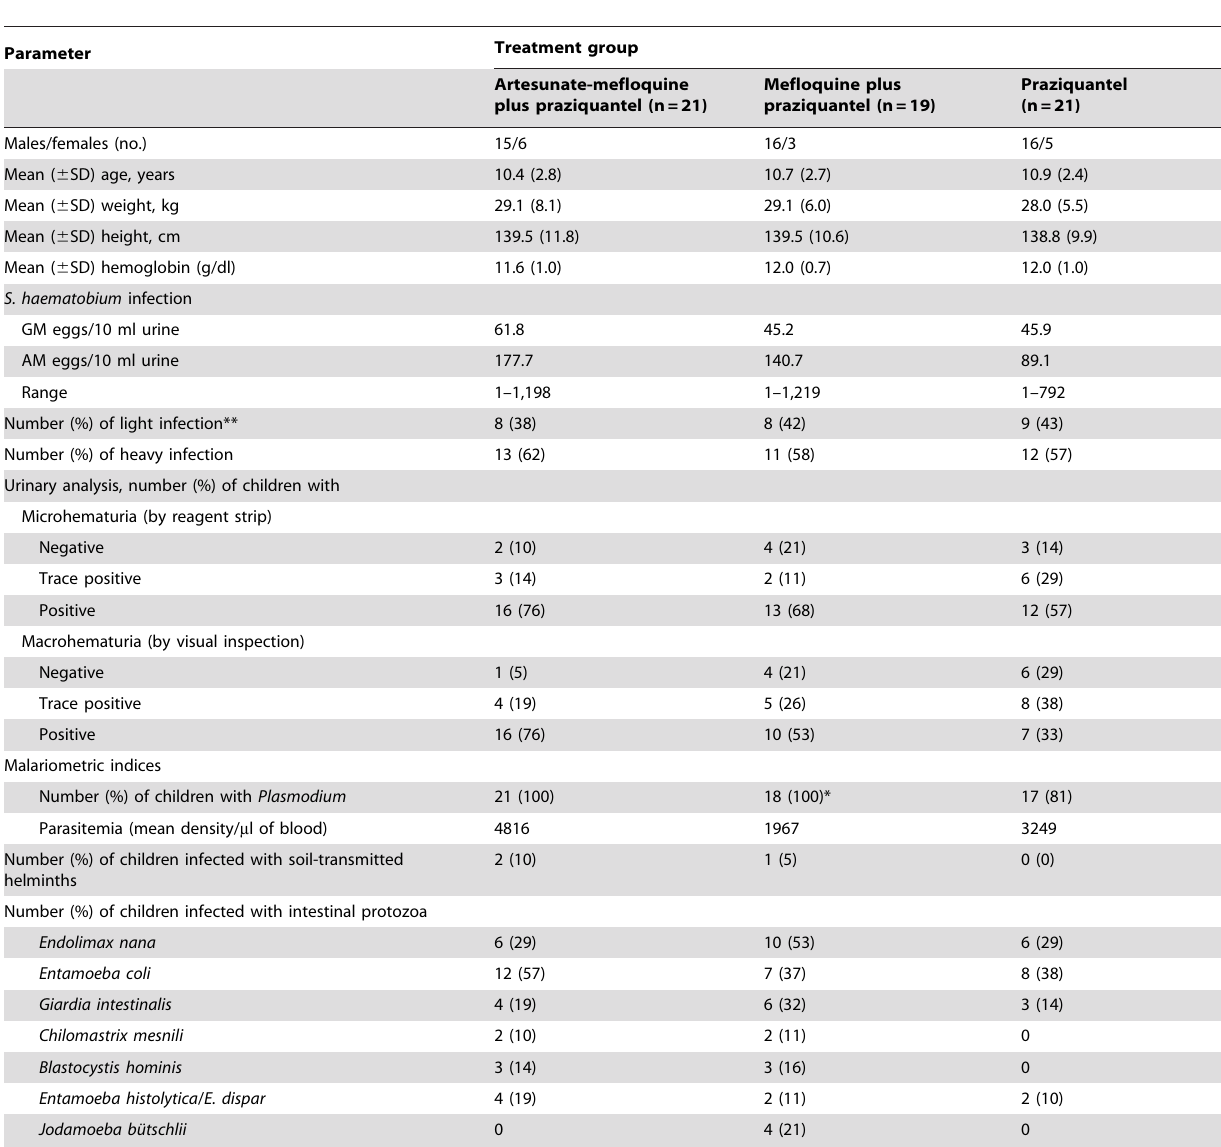
Table 1. Demographic and laboratory baseline characteristics of S. haematobium -infected children treated with mefloquine- artesunate plus praziquantel, mefloquine plus praziquantel, and